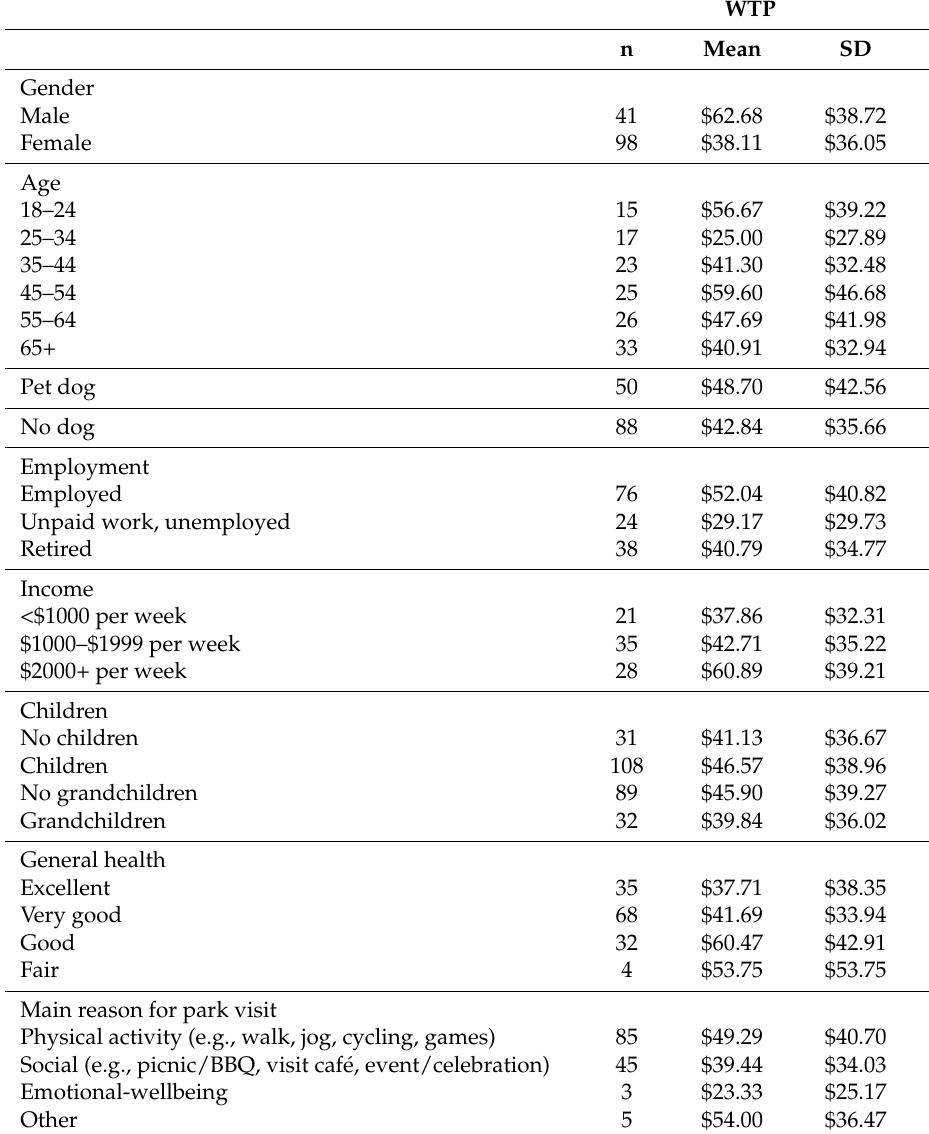
Table 5. Park users WTP by demographic characteristics and survey responses. All dollar values listed are in